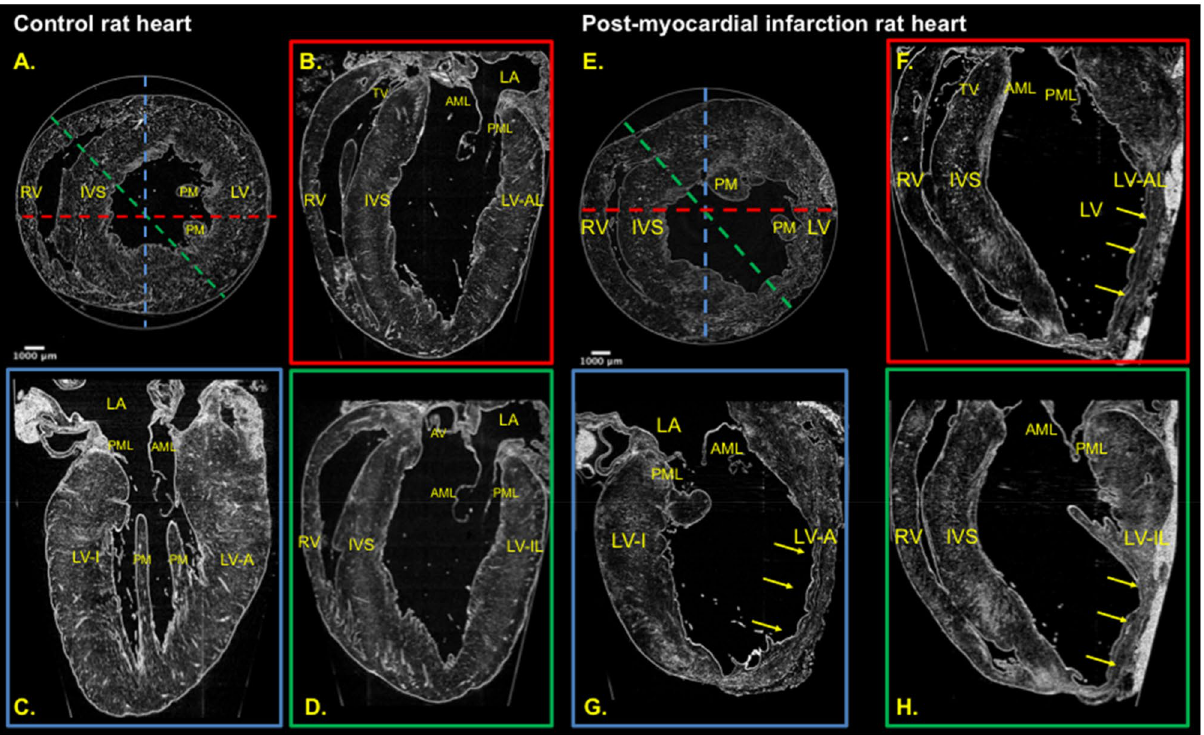
Figure 1. PB X-PCI images reconstructed as conventional imaging views. Control heart from one healthy rat was used for left panel images, and infarcted heart from rat with induced myocardial infarction was used for the right panel. Left panel—control; right panel—infarct. ( A ) Short axis view, ( B ) Apical 4 chamber view, ( C ) Apical 2 chamber view, ( D ) Apical 5 chamber view; ( E ) Short axis view, ( F ) Apical 4 chamber view, ( G ) Apical 2 chamber view, ( H ) Apical 5 chamber view. The dashed lines indicate the position of the slice perpendicular to the short axis, producing a specific longitudinal view. Short yellow arrows indicate the infarct areas with clear aneurysm formation. LV: left ventricle, RV: right ventricle, PM: papillary muscle, IVS: interventricular septum, PML: posterior leaflet of mitral valve, AML: anterior leaflet of mitral valve, TV: tricuspid valve, LA: left atrium, AV: aortic valve, LV-AL: anterolateral wall of the left ventricle, LV-A: anterior wall of the left ventricle, LV-I: inferior wall of the left ventricle, LV-IL: inferolateral wall of the left ventricle.